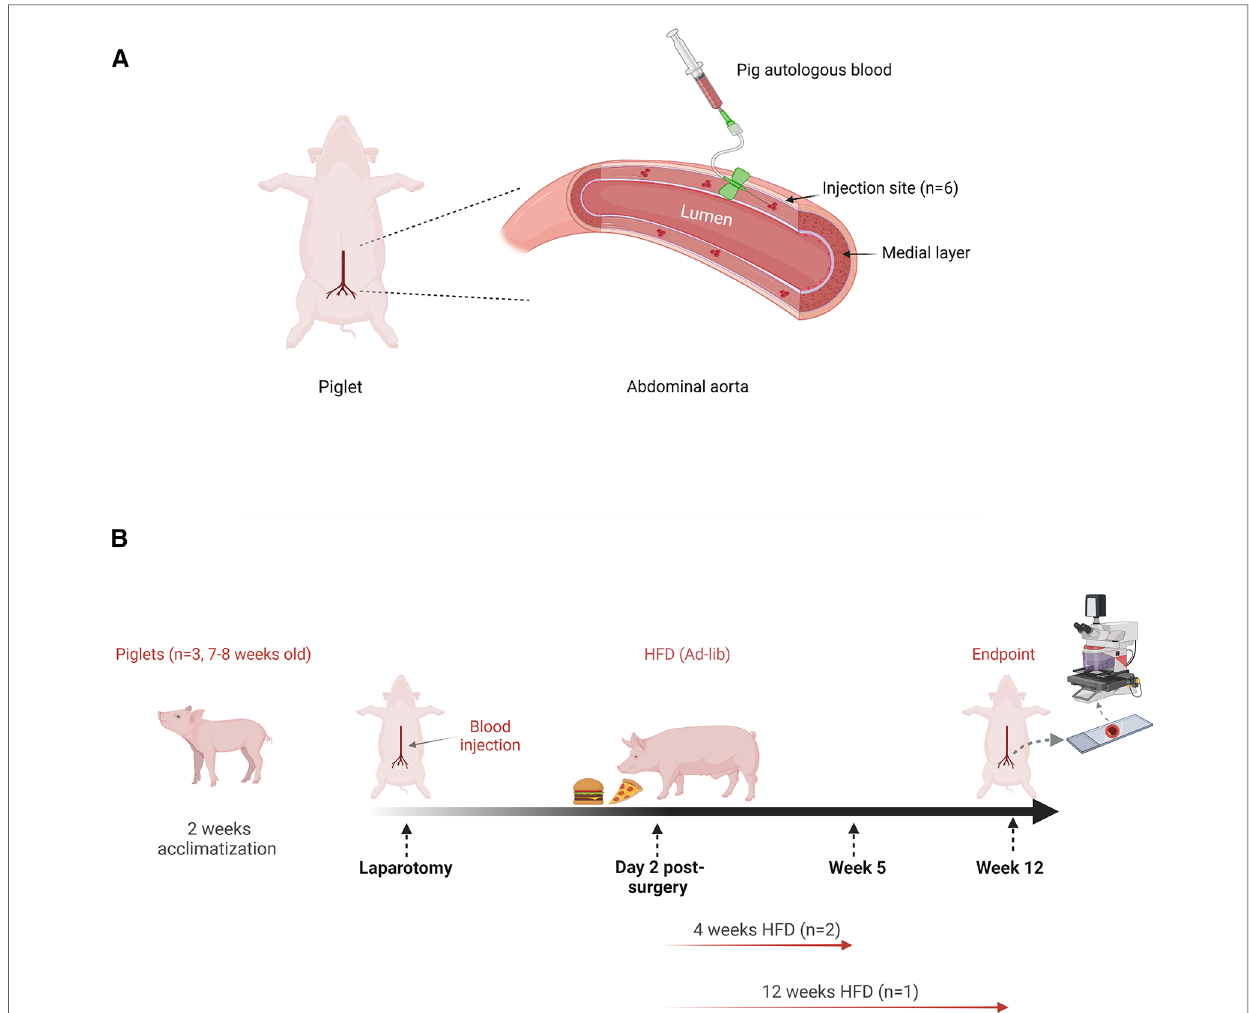
FIGURE 1 Autologous blood injection in the abdominal aorta of pigs and, treatment schedule post-laparotomy. ( A ) Schematic diagram indicating autologous blood (50 – 100 ul) was injected into the medial layer of the lower abdominal aorta at 6 individual sites, following lower midline laparotomy. ( B ) High-fat diet (HFD) was given ad-lib on day two post-surgery, until the end of the experiment (12 weeks, one pig) or four weeks only and then switched to normal chow diet for 8 weeks (4 weeks, two pigs). Body weight and blood were collected weekly to measure plasma lipids. The aorta from all animals was harvested for histology analysis. Image created by biorender.com, under